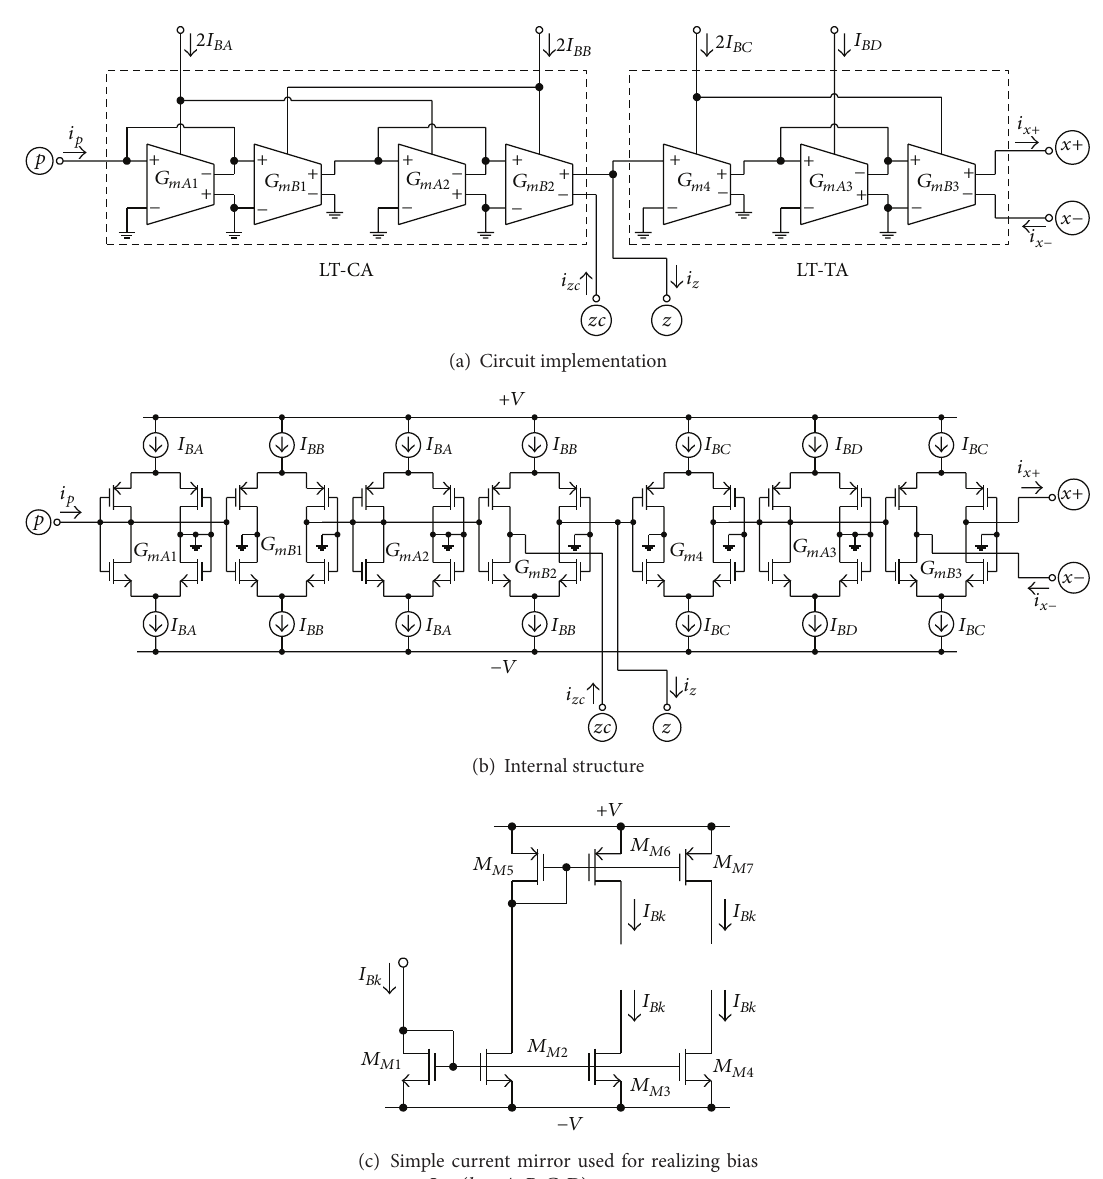
(c) Simple current mirror used for realizing bias currents 𝐼 𝐵𝑘 (𝑘 = 𝐴,𝐵,𝐶,𝐷) Figure 6: Proposed CG-CFTA.